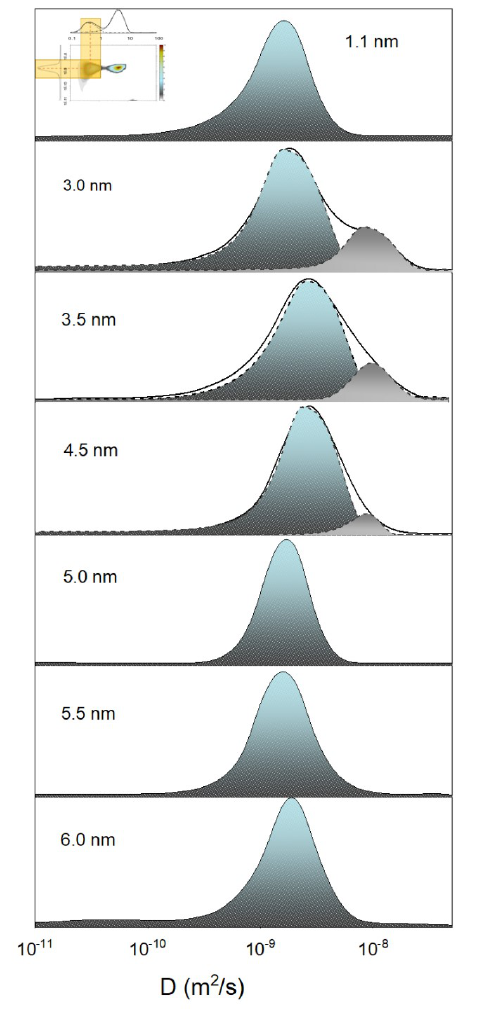
Figure 5. 1 H NMR diffusion projections (solid lines) from the D-T 2 ef f spectra of the internal nanotube water in different CNT sizes at 285K, where T 2 ef f denotes the effective transverse relaxation time, which includes the effects of diffusion. Diffusion projections at certain CNT sizes (3.0nm, 3.5nm, and 4.5nm) are resolved into two components (dashed curves), represented by the main and the shoulder peaks. Reprinted from Ref. [64], with the permission of AIP